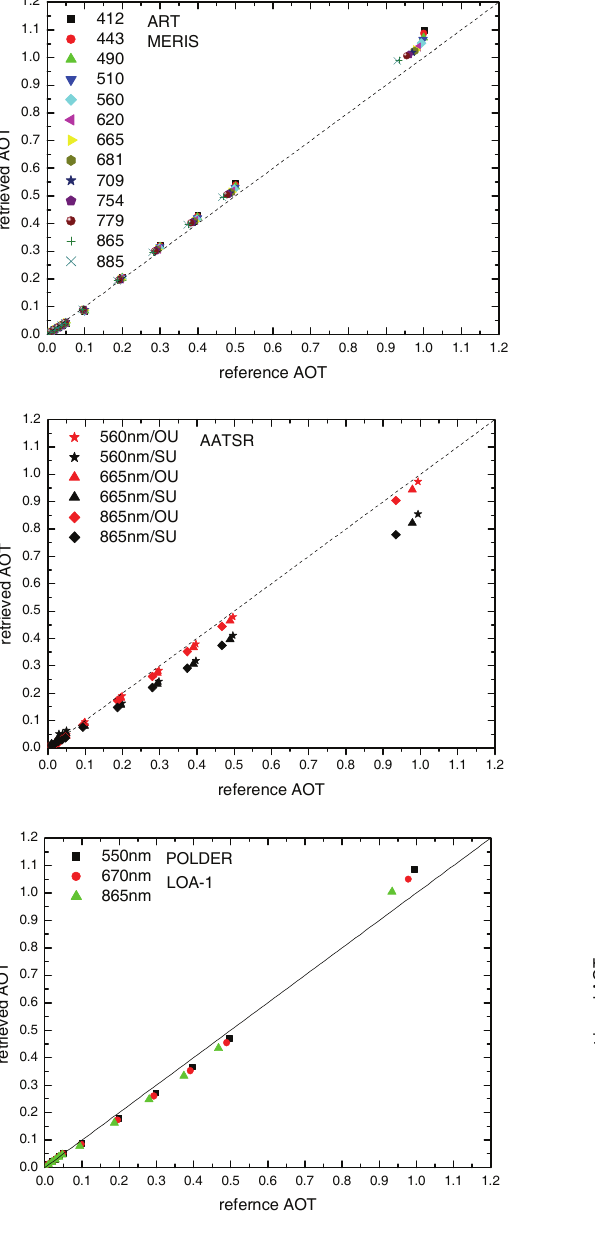
Fig. 14. The comparison of retrieved and reference spectral AOTs for different